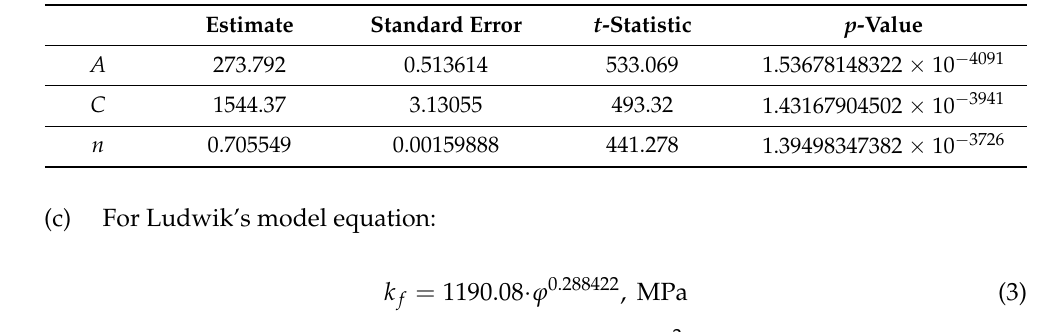
Table 9. Results from regression analysis for Ludwik–Hollomon